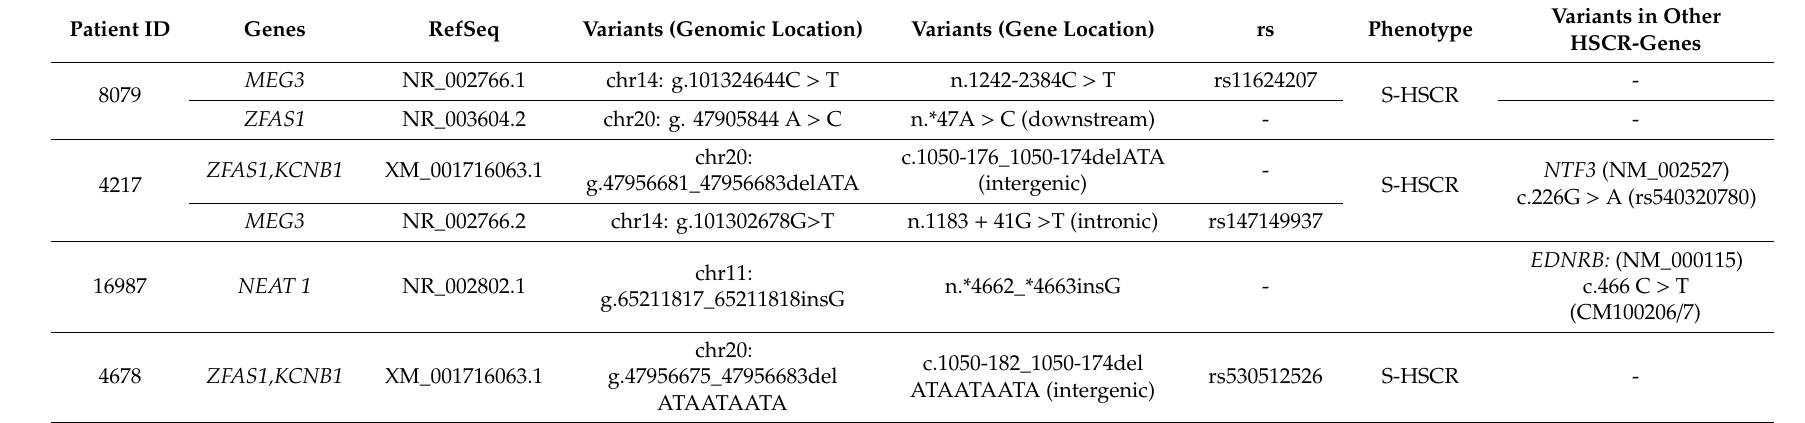
Table 2. Sequence variants (MAF ≤ 0.01) determined in lncRNAs identified in human